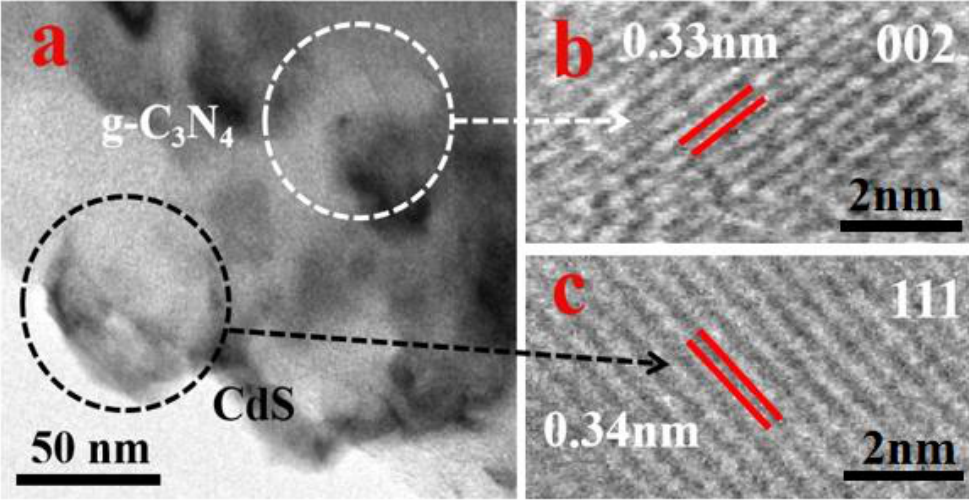
Figure 4. The TEM of PAN/g-C 3 N 4 /CdS heterojunction, ( a ) the TEM of the interface, ( b ) the HRTEM of g-C 3 N 4 , and ( c ) the HRTEM of CdS.